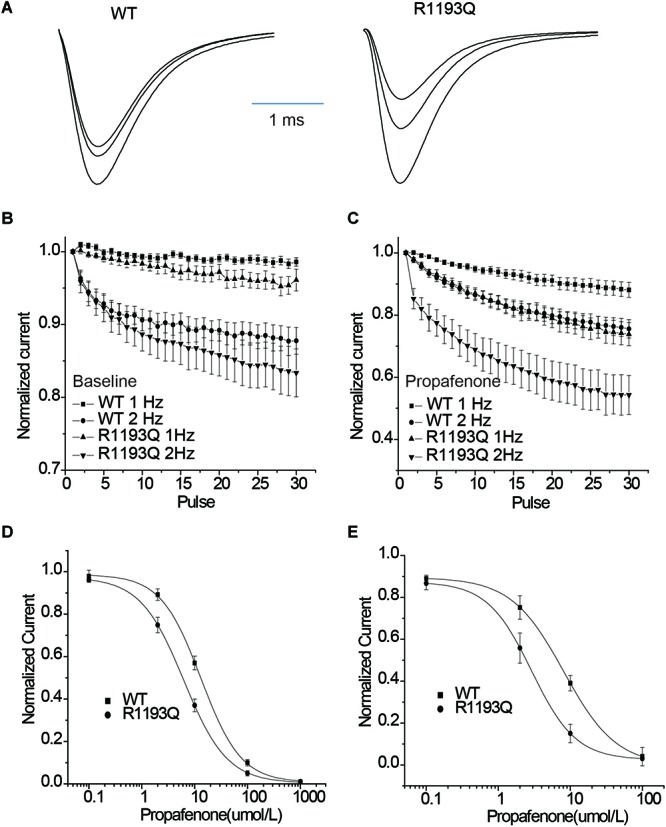
(A) Whole-cell current recordings of UDB showed representative current traces (1st, 15th, and 30th) that have been normalized to facilitate comparison of WT and R1193Q in the presence of propafenone (2 μmol/L). (B) Graph showed UDB for WT and R1193Q channel in the absence of propafenone at 1 and 2 Hz pacing. Plots of normalized peak Na+ current against the number of depolarizing pulse to –10 mV from a holding potential of –100 mV for 400 ms, n = 7 to 14 cells per condition. (C) Graph showed UDB for WT and R1193Q channel in the presence of propafenone (2 μmol/L) at 1 and 2 Hz pacing, n = 8–13 cells per condition. R1193Q exhibited more sensitive to propafenone; at 2 Hz pacing, the UDB of WT and R1193Q was 24.8 ± 3.5 and 44.2 ± 5.7%, respectively, P < 0.05. (D) Concentration dependence of UDB by propafenone at 1 Hz pacing, n = 6 for each concentration. IC50 values were 13.2 ± 2.6 μmol/L for WT and 6.2 ± 1.3 μmol/L for R1193Q. (E) Concentration dependence of UDB by propafenone at 2 Hz pacing, n = 6 for each concentration. IC50 values were 8.1 ± 1.8 μmol/L for WT and 2.9 ± 0.7 μmol/L for R1193Q.